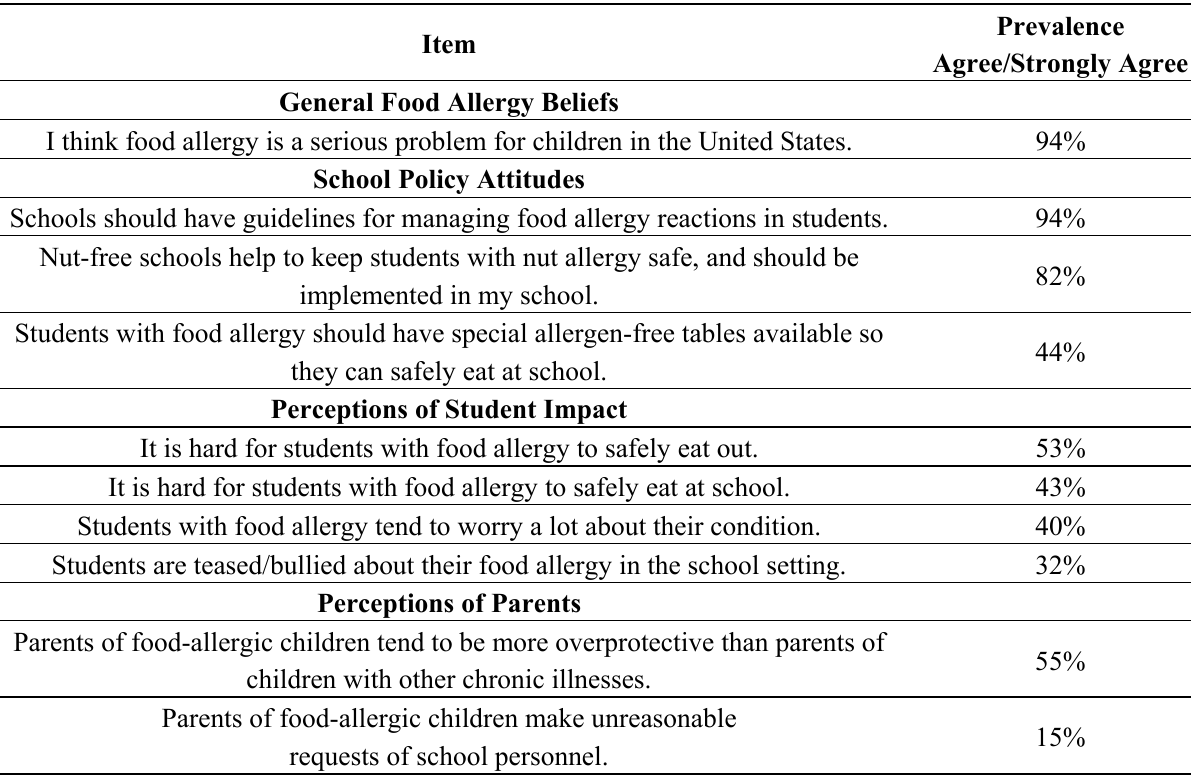
Table 4. School nurse attitudes towards food allergy.